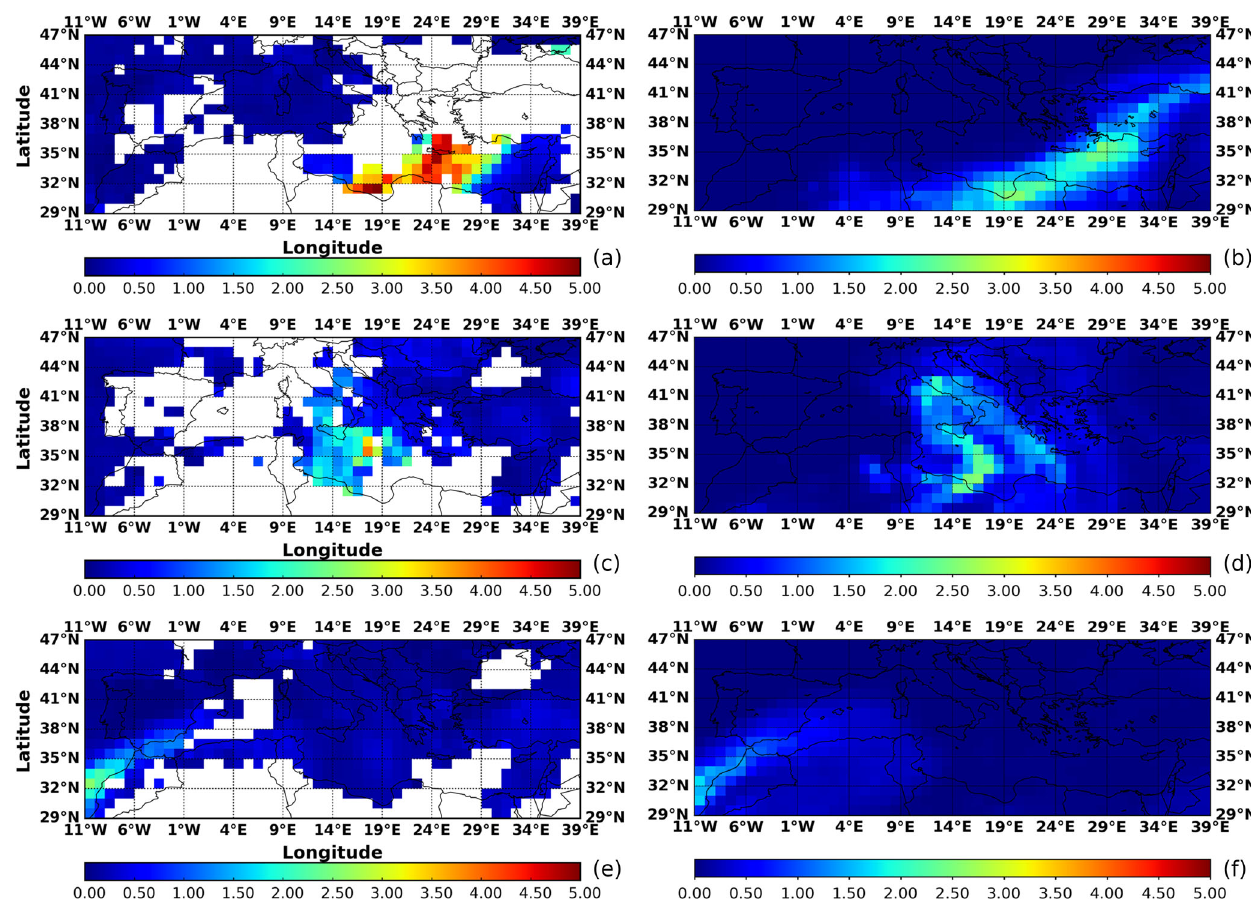
Figure 3. Geographical distributions of the aerosol optical depth (AOD) at 550nm: (a, c, e) retrieved by the MODIS-Terra sensor and (b, d, f) simulated by the NMMB-MONARCH model at 12:00UTC for the Mediterranean desert dust outbreaks that took place on (a, b) 2 March 2005, (c, d) 19 May 2008 and (e, f) 2 August